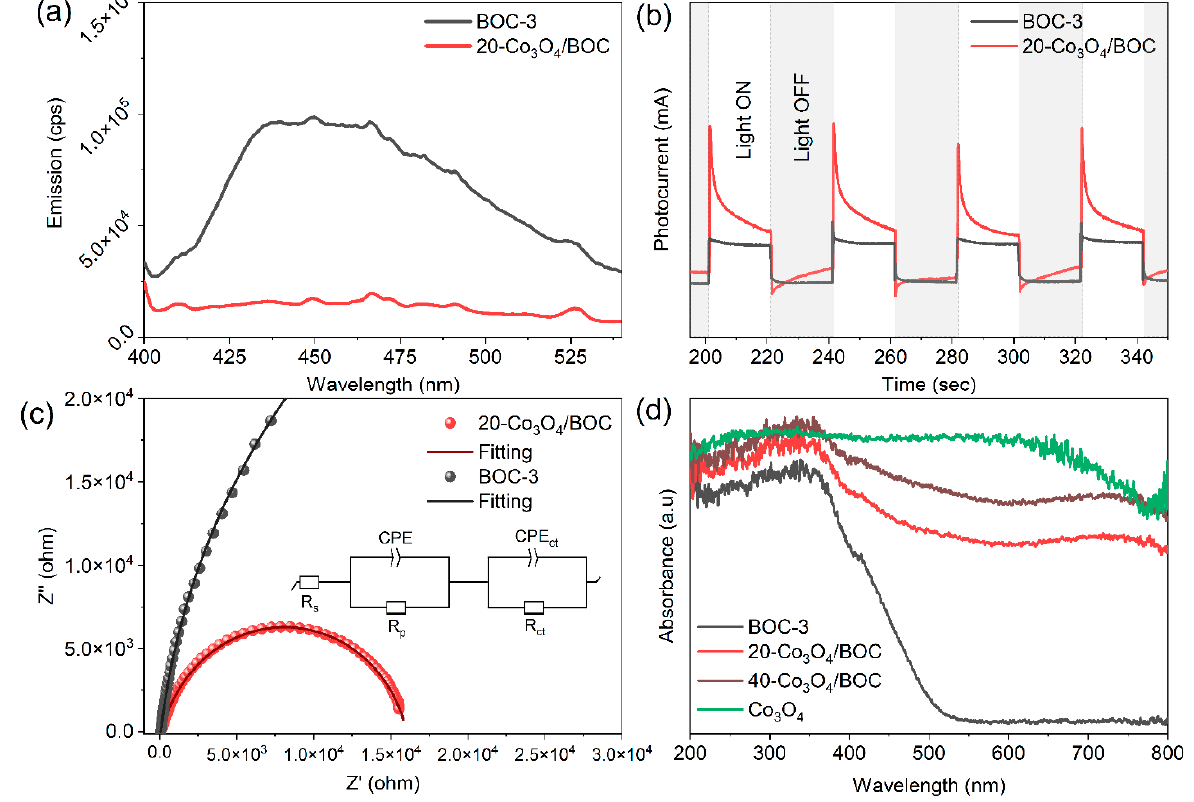
Figure 4. ( a ) Photoluminescence spectra, ( b ) Transient photocurrent response, ( c ) EIS Nyquist plots of BOC-3 and 20-Co 3 O 4 /BOC samples, and ( d ) UV–Vis diffuse reflectance spectra of Co 3 O 4 , BOC-3, 20-Co 3 O 4 /BOC, and 40-Co 3 O 4 /BOC.